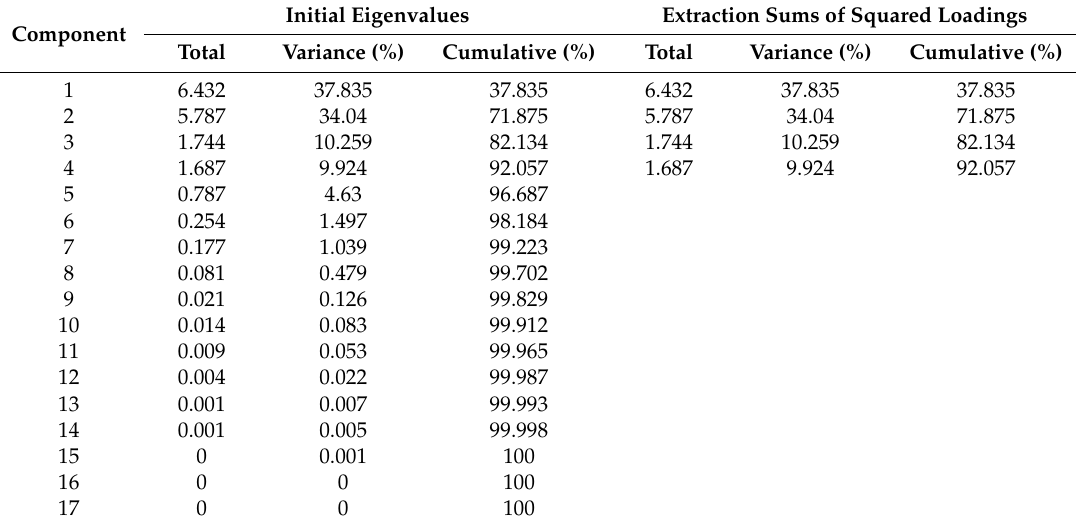
Table 4. Total variance